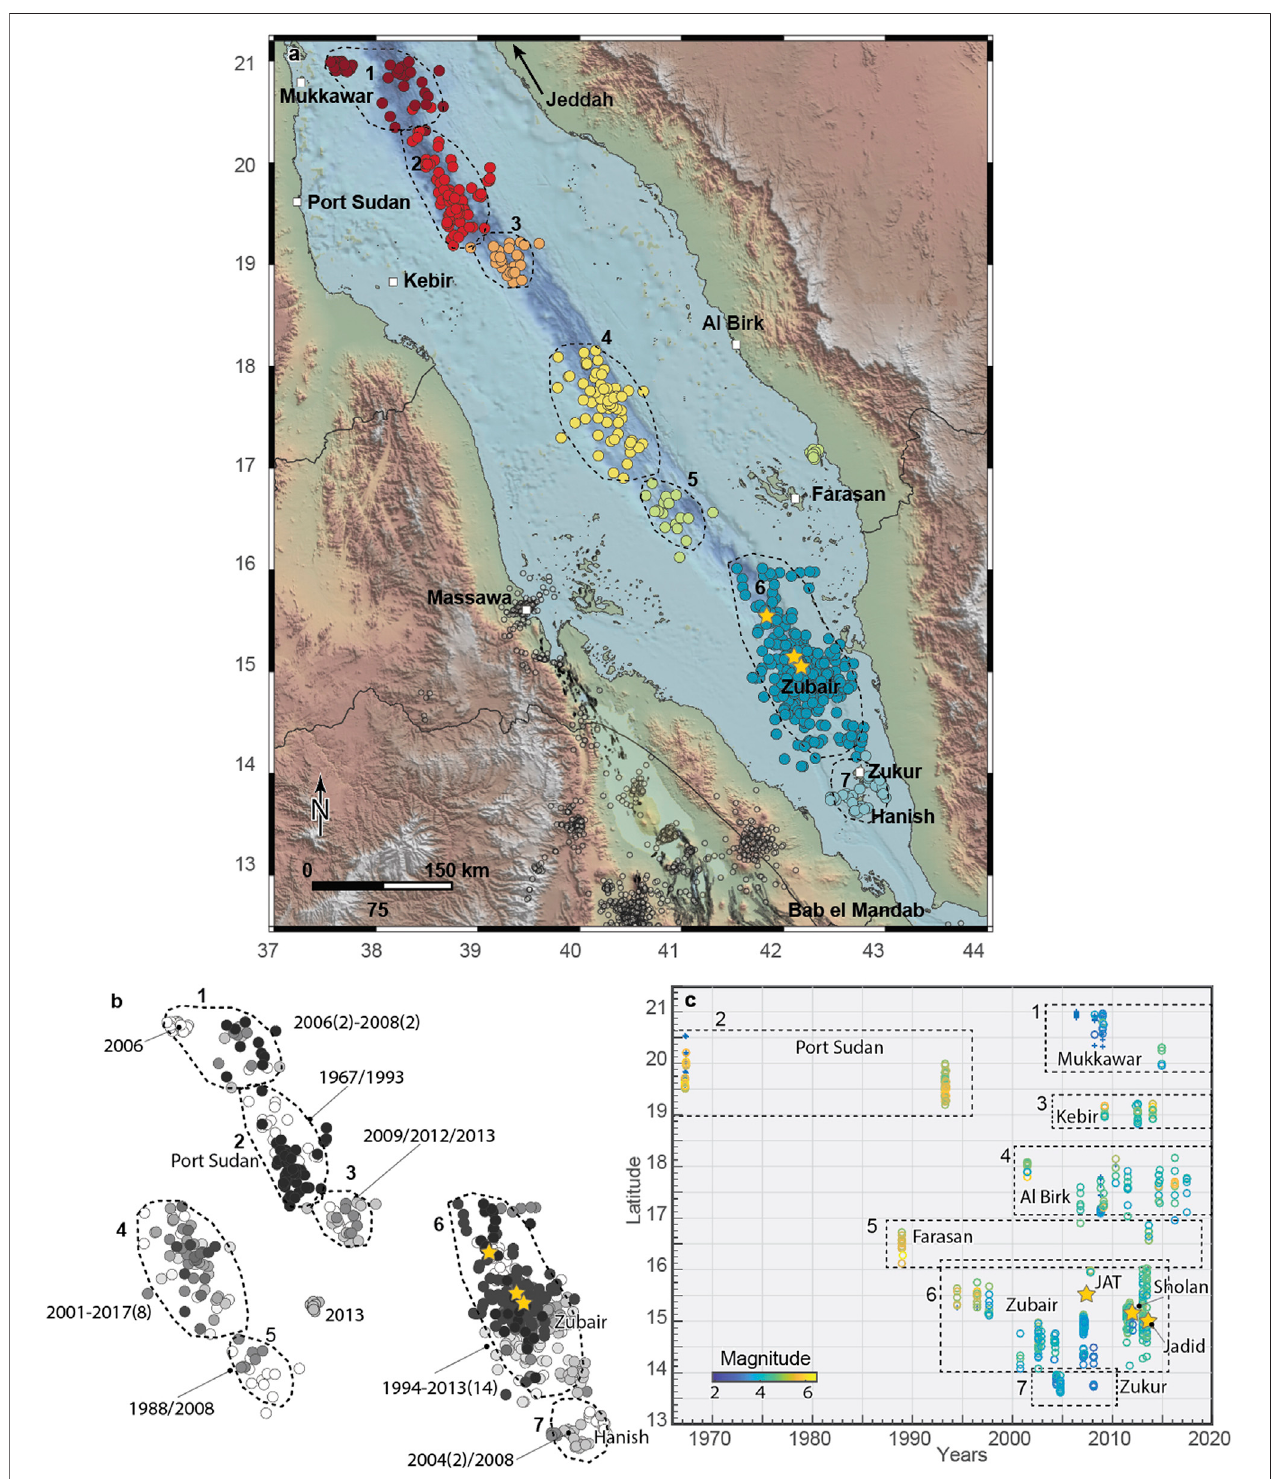
FIGURE 4 | Earthquake swarms in the southern Red Sea from 1960 to 2017. (A) Seven different clusters were identi fi ed along the southern Red Sea rift axis. (B) Each cluster contains several earthquake swarms whose timing is indicated by the grey gradient from white (older events) to black (younger events). The larger swarms are marked by the year of occurrence with the number of swarms for the noted period in brackets. (C) Swarm latitude as a function of time for the different clusters, with colors showing event magnitudes, blue stars earthquakes with no magnitudes, and yellow stars volcanic eruptions.